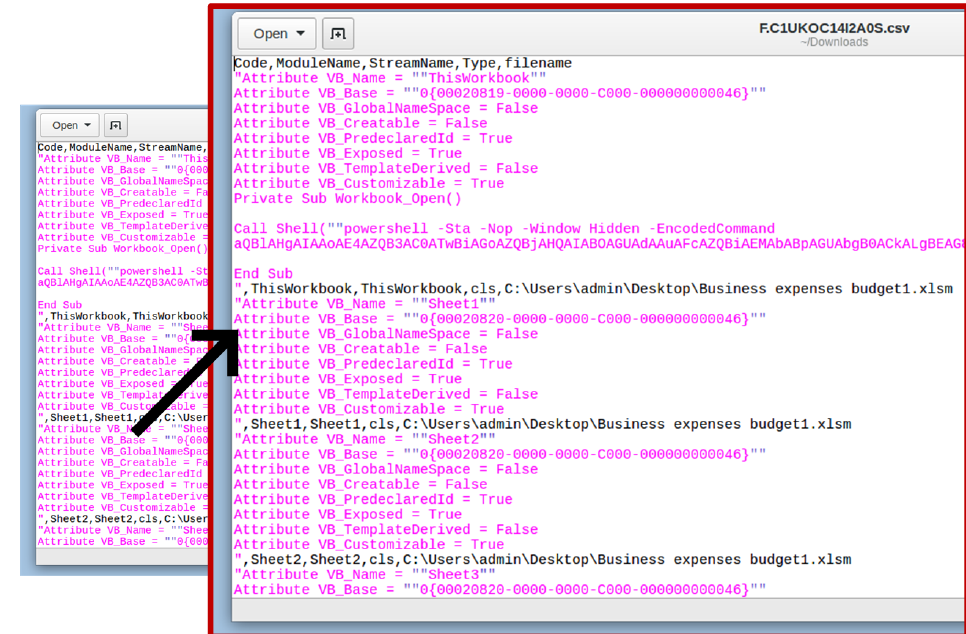
Figure 11. Validation of user action.